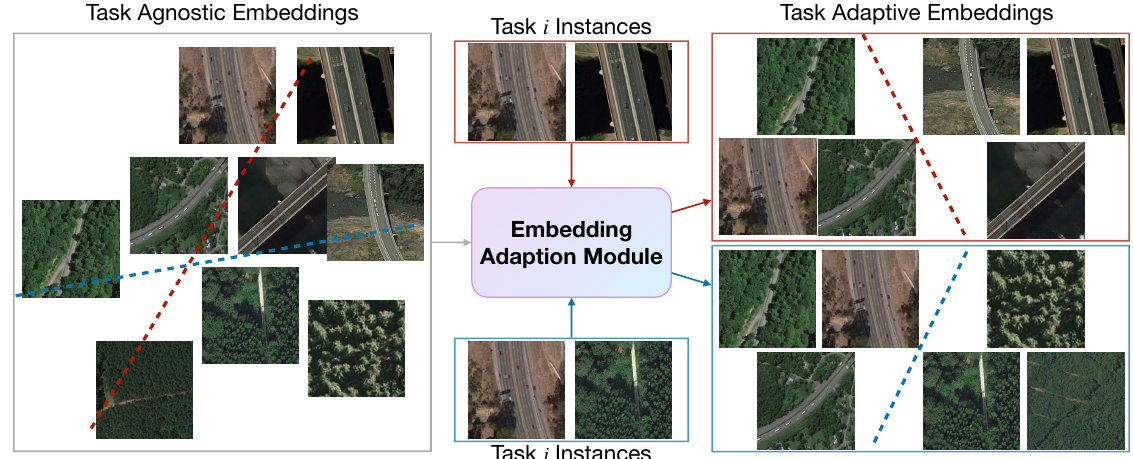
Figure 2. An illustration of the difference between task-agnostic and task-adaptive